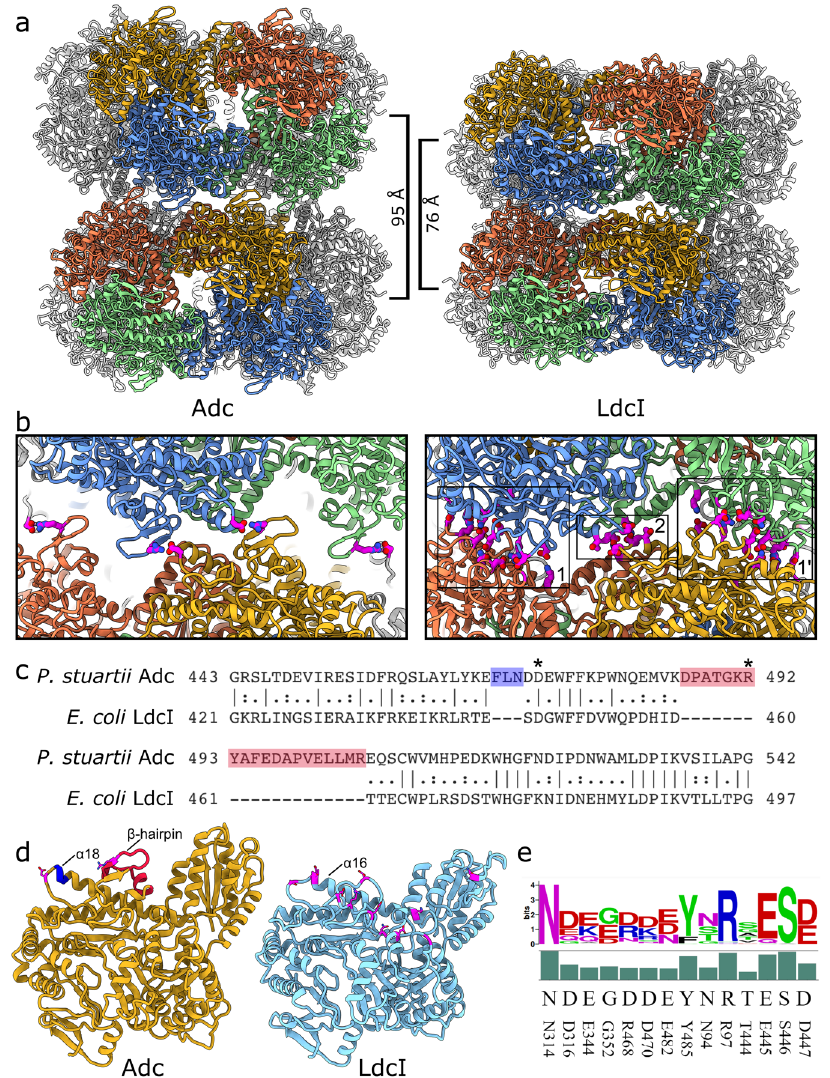
Fig. 3 Comparison between Adc and LdcI stack formation. a Atomic model of two-decamer Adc and LdcI stacks. The closer packing of decamers in the LdcI stack reduces the repeat distance between decamers in the stack from 95 Å to 76 Å. b Close-up view of the decamer interfaces in the Adc stack and LdcI stack. Stack-forming residues are shown in magenta as sticks. The decamer:decamer interface in the Adc stack is equivalent to interface annotated ‘ 2 ’ in the LdcI stack, with an offset due to the inserted β -hairpin in Adc. This insertion, along with a 3-amino acid insertion at the end of α -helix α 18, has the effect of pushing the decamers further apart in Adc with the consequence that there is no interface in Adc equivalent to interface ‘ 1 ’ in LdcI, reducing the total buried surface area between two decamers from 6108 Å 2 to 1609 Å 2 . c Pairwise sequence alignment of LdcI and Adc in the beginning of the AAT- like domain, with insertions in Adc highlighted in green and red. The key stack-forming residues in Adc D472 and R492 are marked with an asterisk. d Monomeric structures of LdcI and Adc, with stack-forming residues shown in magenta as sticks. The Adc insertions highlighted in c are shown on the Adc structure in the same colours. e Conservation of the 14 residues involved in interfaces 1 and 2 of the LdcI stack formation across the Cluster II LdcIs represented as a sequence logo. The bar chart indicates the relative frequency of the consensus sequence residues. Residue numbers are from the E. coli LdcI